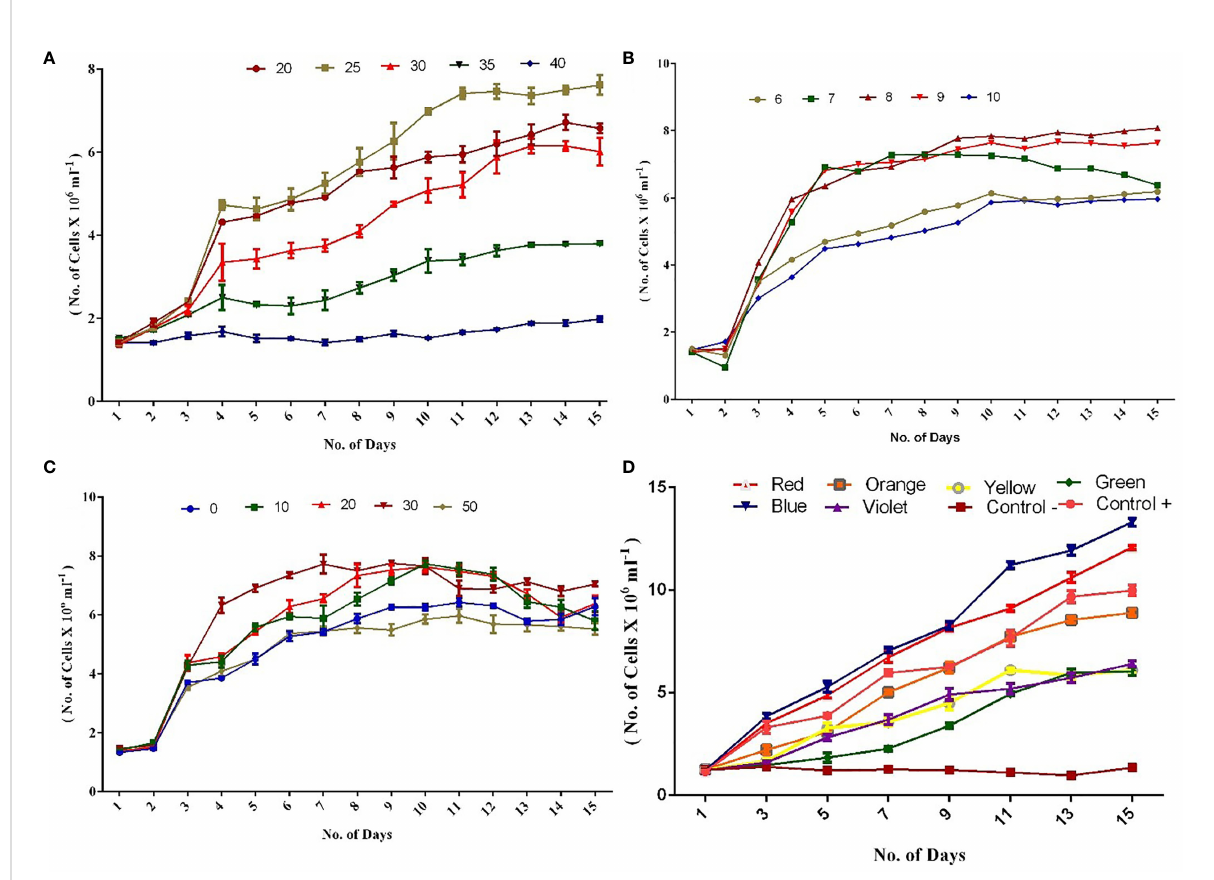
FIGURE 1 (A) Growth of C. vulgaris culture at different temperature. (B) Growth of C. vulgaris culture at different pH. (C) Growth of C. vulgaris culture at different salinities. (D) Growth of C. vulgaris culture at different light intensities. (Experiments were conducted in triplicate and the values are expressed as mean ±